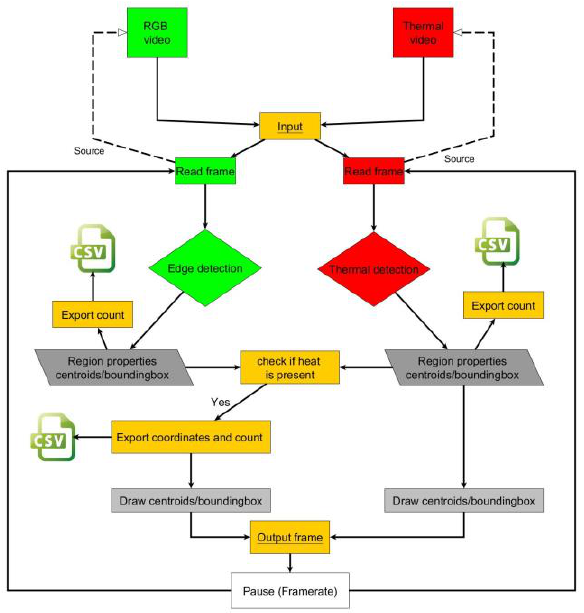
Figure 6. Schematic illustration of the near real-time fusion process of RGB and thermal video data.